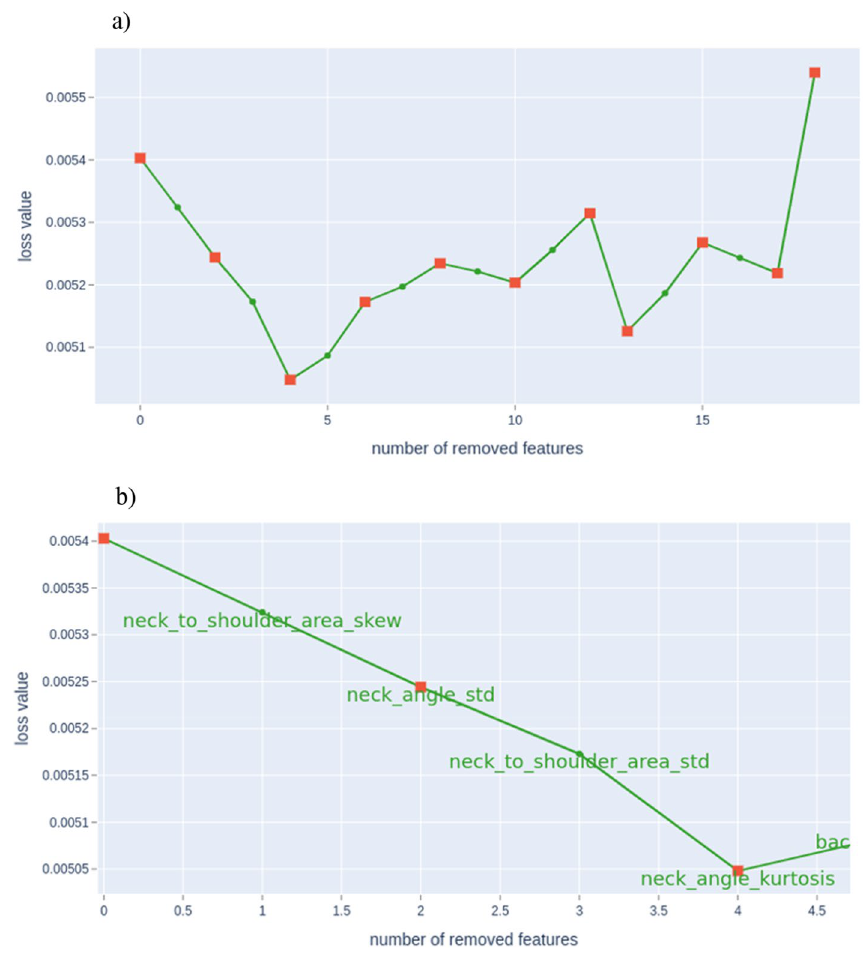
Figure 2. ( a ) The change in error for features removed using the recursive feature elimination algorithm on the Catboost model. The model achieves its lowest error value once 4 features are removed. ( b ) The change in error for the first 4 features removed using the recursive feature elimination algorithm on the Catboost model. The 4 features removed to reduce the error are ‘neck to shoulder area skew’, ‘neck angle standard deviation’, ‘neck to shoulder area standard deviation’ and ‘neck angle